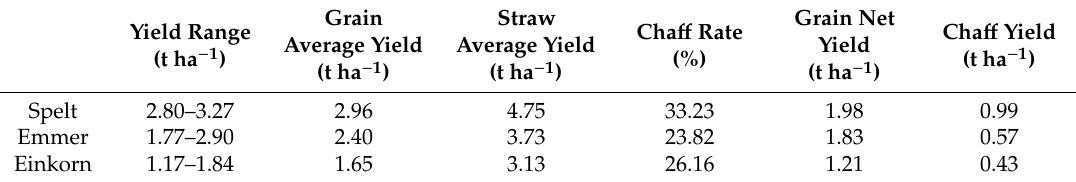
Table 2. Field trials results.